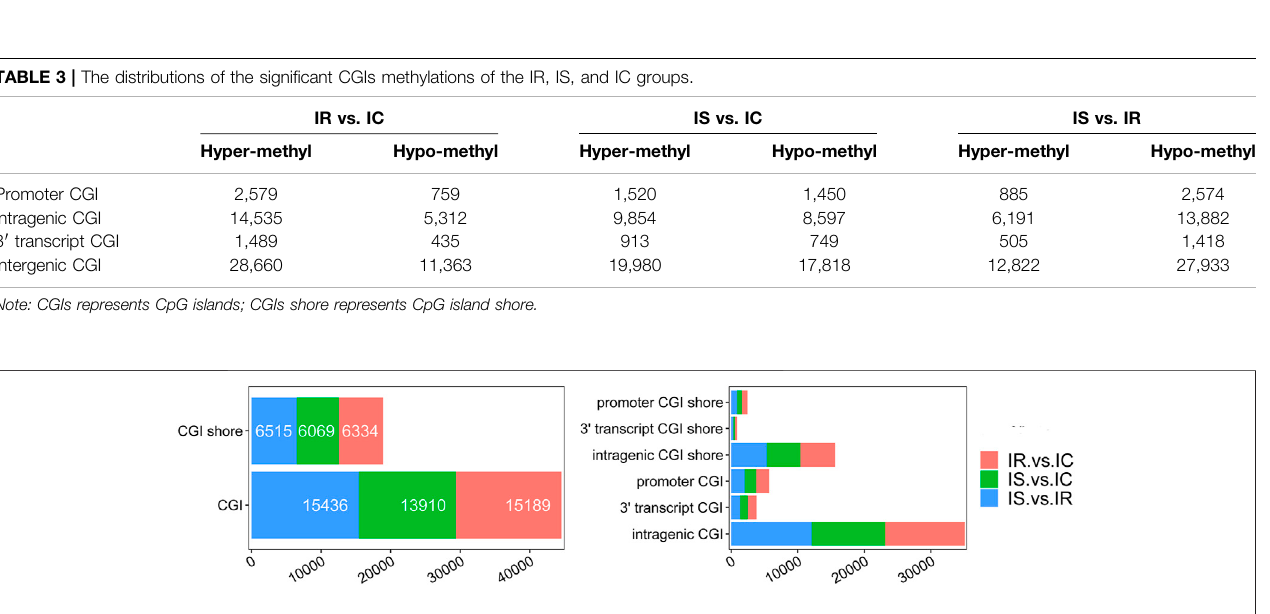
Frontiers in Genetics |